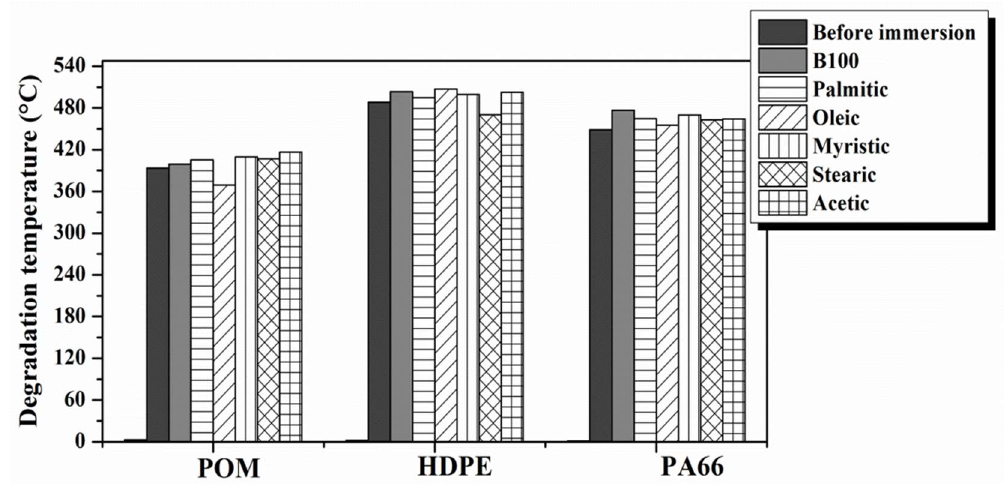
Figure 9. Degradation temperature extracted from thermogravimetric analyses performed on polymer samples before and after exposure to B100 and B100–acid blends.